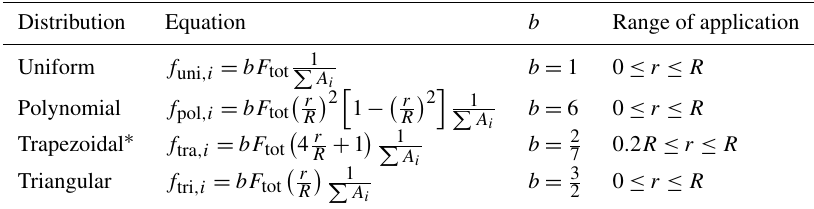
Table 2. Thrust distributions over the disc, where r is the distance from the centre of the disc and R is the radius of the disc. Note that f on the left-hand side of the equations has dimensions of force per unit area.